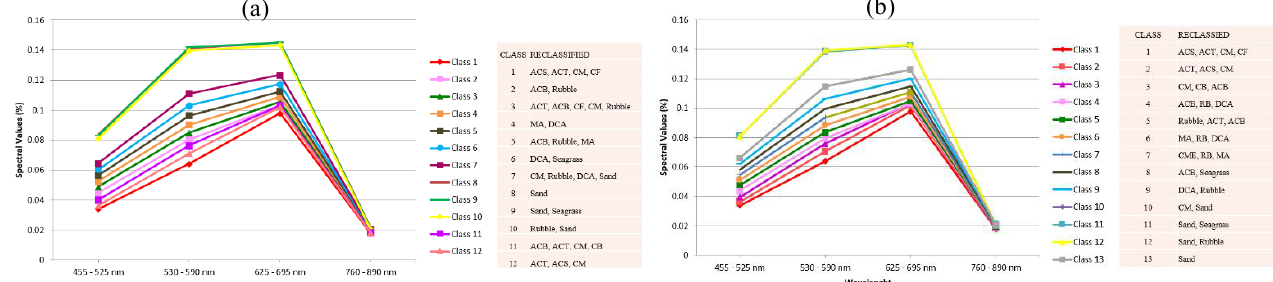
Figure 6. Spectral reflectance pattern of water base objects based on IsoData and K-Means method on SPOT-6 image, (a) Spectral reflectance pattern with IsoData method, (b) Spectral reflectance pattern using K-Means method.